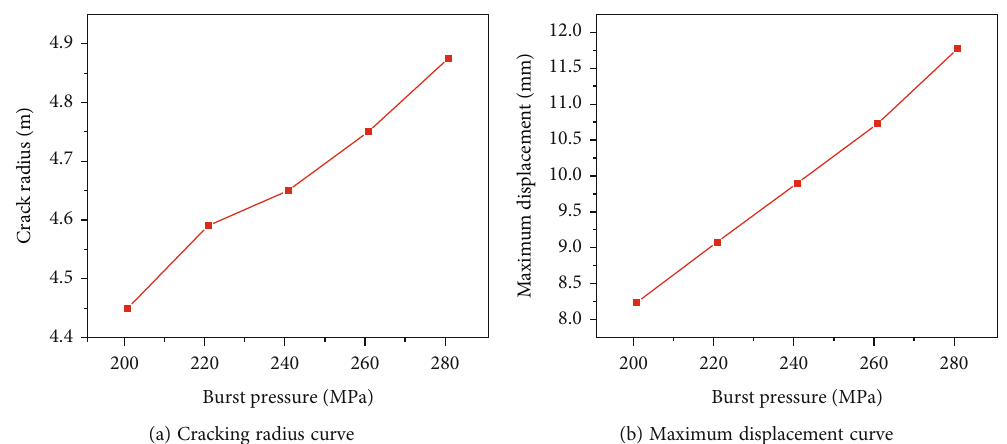
Figure 8: Fracturing radius and maximum displacement under di ff erent blasting pressures.